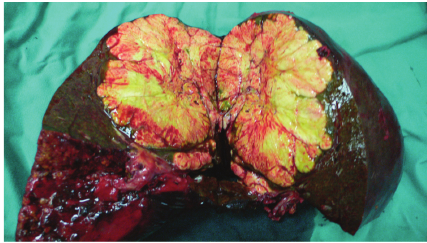
Figure 6: Specimen of the resected